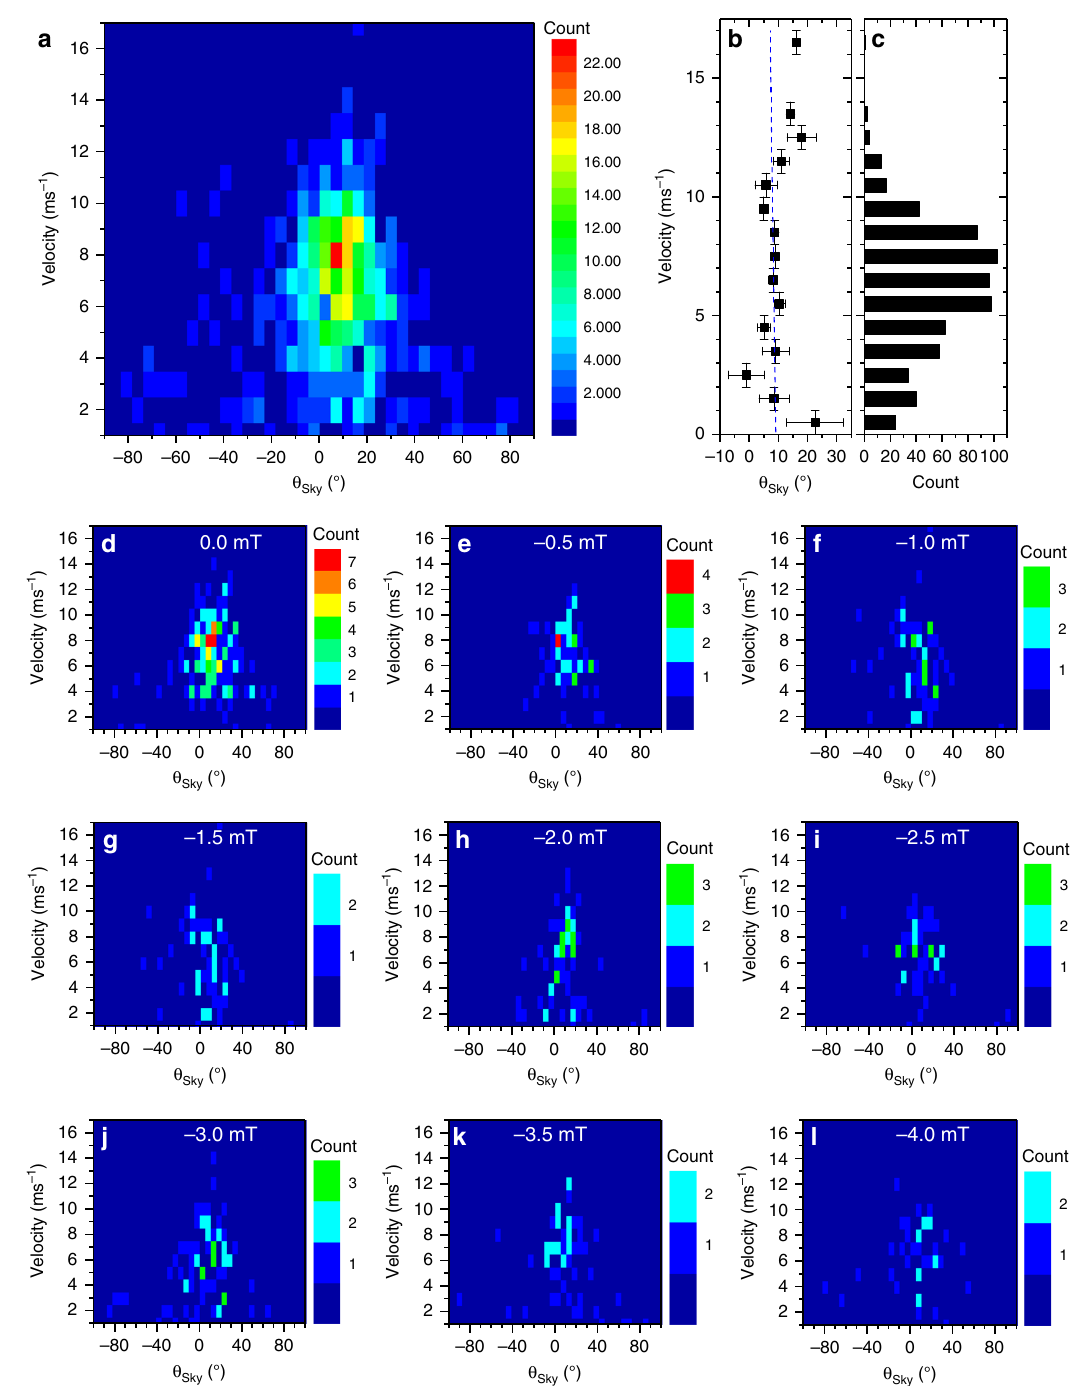
Fig. 4 Relationship between skyrmion Hall angle and skyrmion velocity. a Frequency count of skyrmion velocity versus skyrmion Hall angle θ Sky . The velocity was calculated from the distance travelled, as taken from the skyrmion core position, between consecutive images, i.e., in 18 ns. The velocity and angles were binned into 1 ms − 1 and 5° intervals, respectively. b Average θ Sky versus velocity evaluated from data in a with the respective histogram c . Blue dashed line shows linear fi t to data. Standard errors are plotted. d – l shows velocity-skyrmion Hall angle plots for different applied fi eld. Taken together, these plots will give the overall plot in a